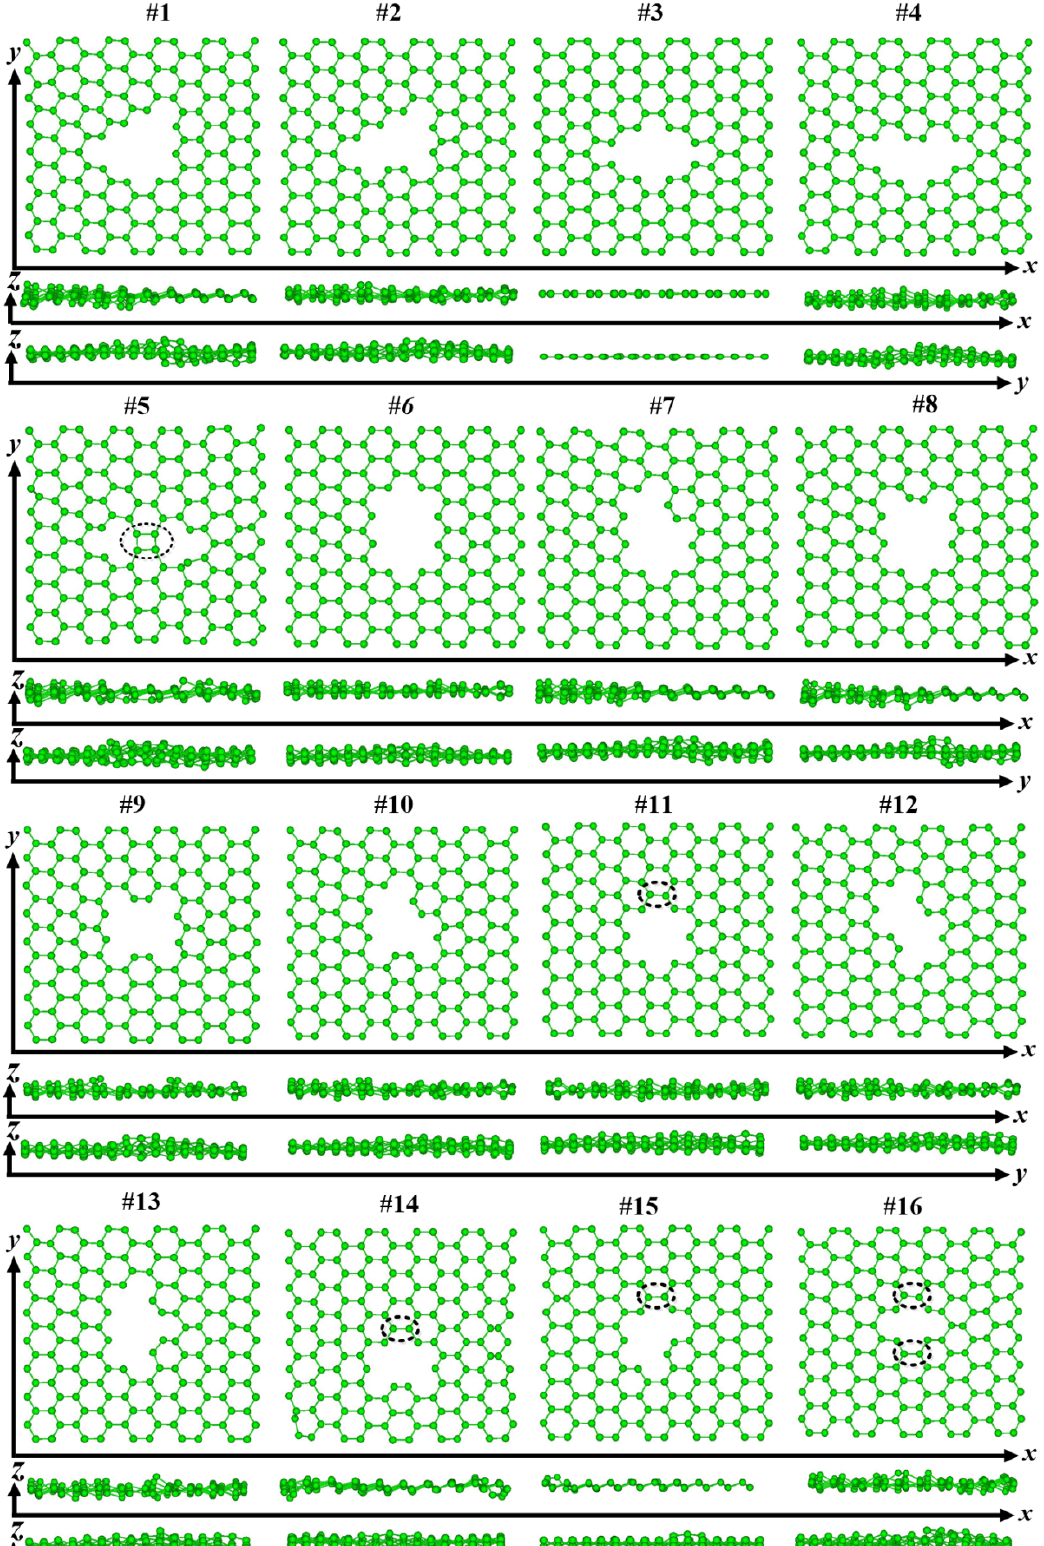
Figure 3. Optimized sixteen possible structures of the grapheme having defects.